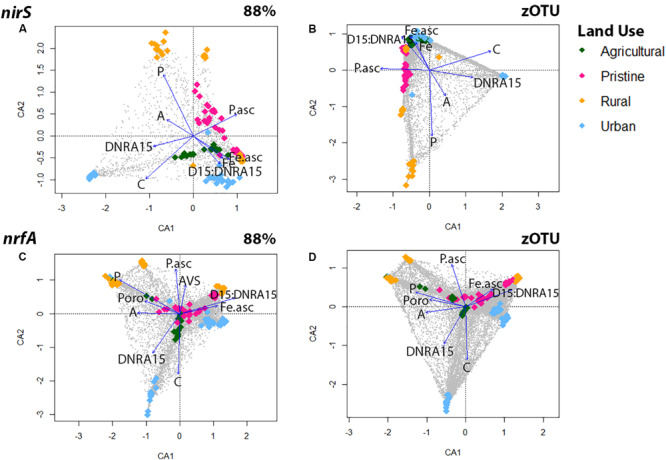
Canonical correspondence analysis (CCA) for the nirS gene using OTUs at the 88% similarity (A) and zOTU threshold (B) and for the nrfA gene using OTUs at the 88% similarity (C) and zOTU threshold (D). Amplicon data were Hellinger transformed to decrease the contribution of abundant species and environmental parameters were standardized with the ‘standardize’ function using decostand from the Vegan Package (Oksanen et al., 2007). Significant (p < 0.05) environmental parameters were derived using the envfit function in Vegan and overlaid as vectors. Environmental parameters from all six depths were: sediment ascorbate-extractible Fe2+ concentrations (Fe.asc in μM); Ascorbate extractible (bound) PO43- (P.asc in μM); Porosity (Poro); NH4+ in pore water (A in μM); Organic carbon (C in μM); Filterable reactive phosphorus in pore water (P in μM), Acid volatile sulfide (AVS in μM). Colors represent land uses and gray dots are the OTUs.